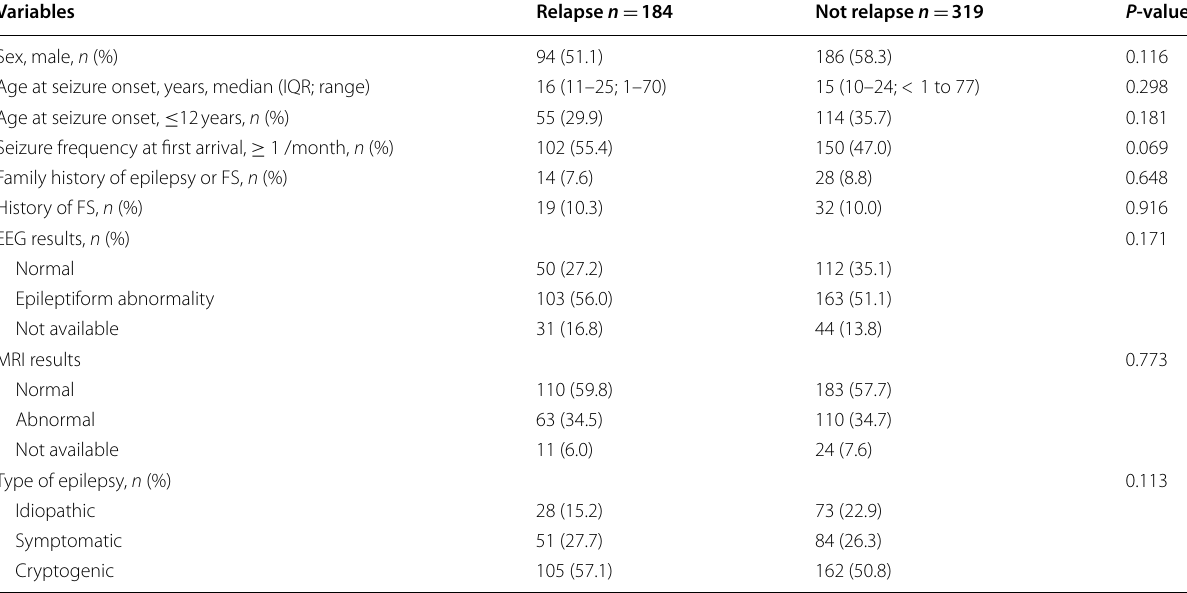
FS febrile convulsions